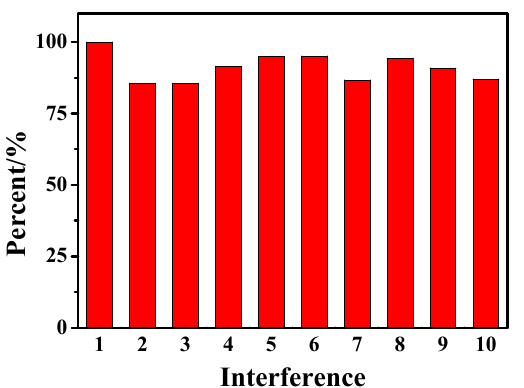
Figure 9. Influence of different interfering substances (interference 1-10 are AC, Na + , CO 32 − , Cl − , glucose, uric acid, rutin, catechol, hydroquinone, and Cr 3+ in sequence) on 1 × 10 − 4 M AC detection with Fe 3 O 4 -rGO/GCE electrodes by SWV method.